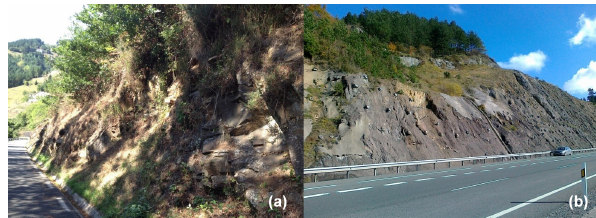
Figure 8. (a) PoR P2A of the road AP-8-1-1 (from km 77.140 to 77.210) where the crest of the slope and the retaining wall with anchors is seen; (b) C8A of the road G-2634 (32.980 to 33.150) with gunite, rock bolts, and